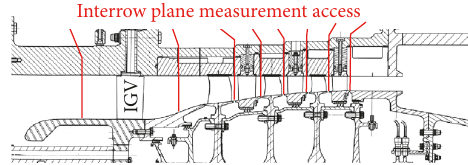
Table 1: Characteristics of CREATE at design point.